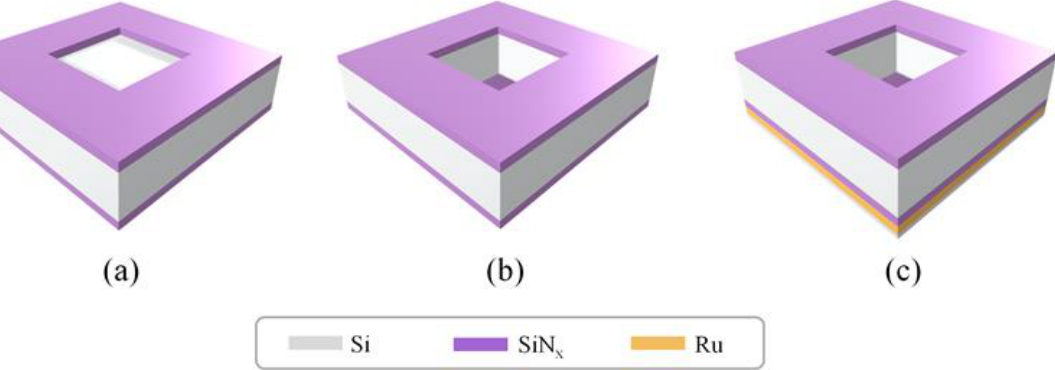
Figure 1. Fabrication of the Ru/SiN x pellicle composite: ( a ) SiN x film deposition using low-pressure chemical vapor deposition (LPCVD) and backside patterning by reactive ion etching, ( b ) fabrication of the SiN x free-standing membrane using the Si wet etching process, ( c ) Ru layer deposition by magnetron sputtering and annealing at 300 and 500 °C using a vacuum furnace.